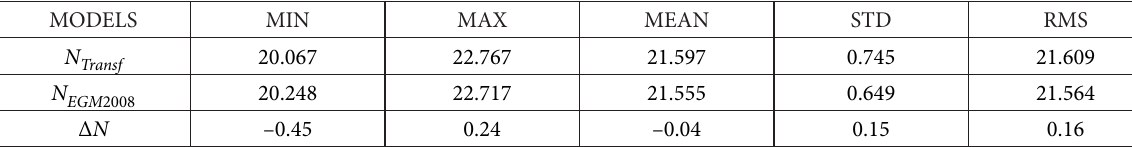
Table 9. Statistics of geoid heights and differences at transformed GPS/Levelling